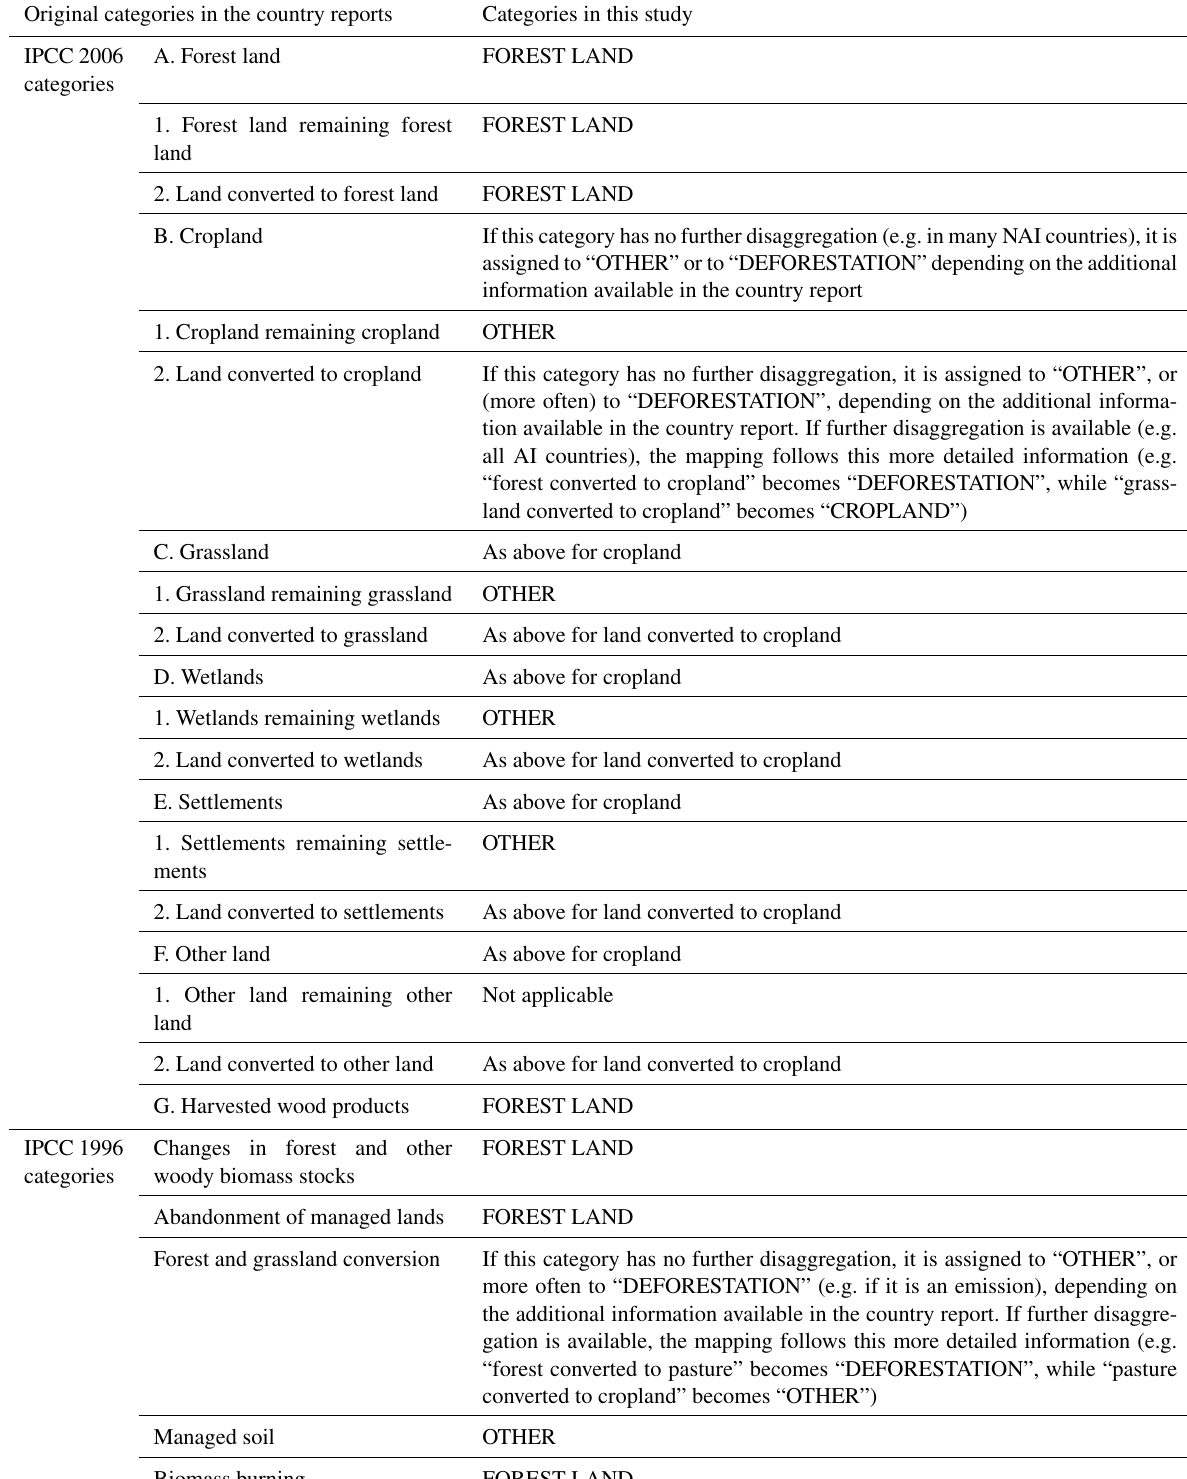
Table 2. Mapping of original categories in the country report (typically those of the IPCC methodology) to the categories used in this study (forest land, deforestation, organic soils,